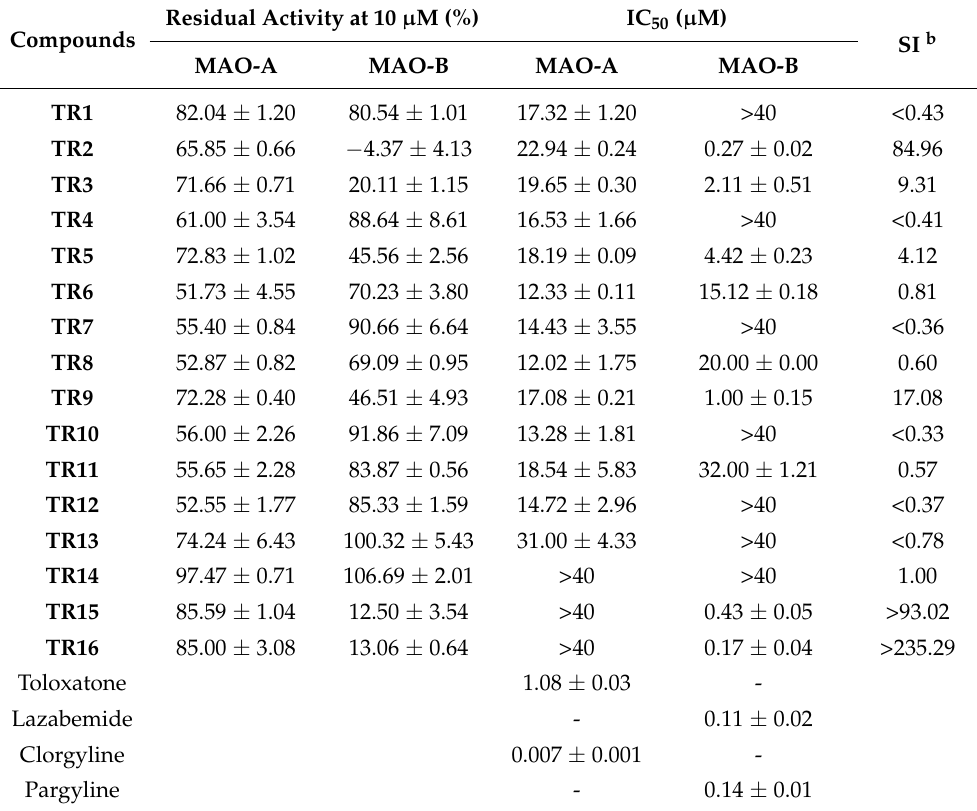
Table 3. Inhibition of MAO-A and MAO-B by the TR series a .